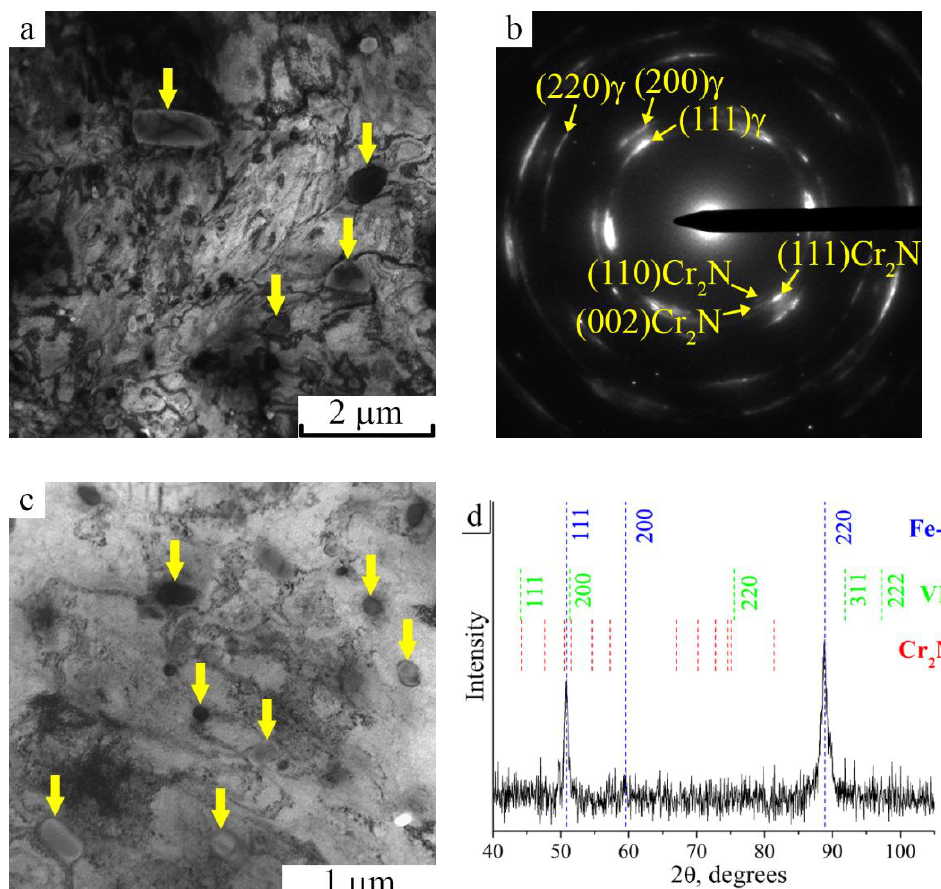
Figure 2. Representative TEM images ( a – c ) and X-ray diffraction pattern ( d ) of the microstructure in steel specimens processed via multistep thermal-mechanical treatment: ( a,c )—bright-field images. Arrows in ( a ) and ( c ) show coarse vanadium nitrides and smaller chromium nitrides in the austenitic structure; b—SAED (selected area electron diffraction) pattern corresponded to the image ( a ) and obtained from the area 0.3 μm 2 .